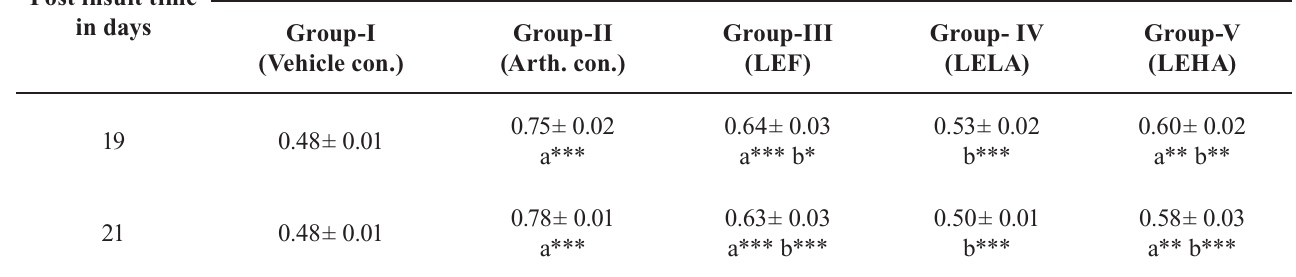
Post insult time